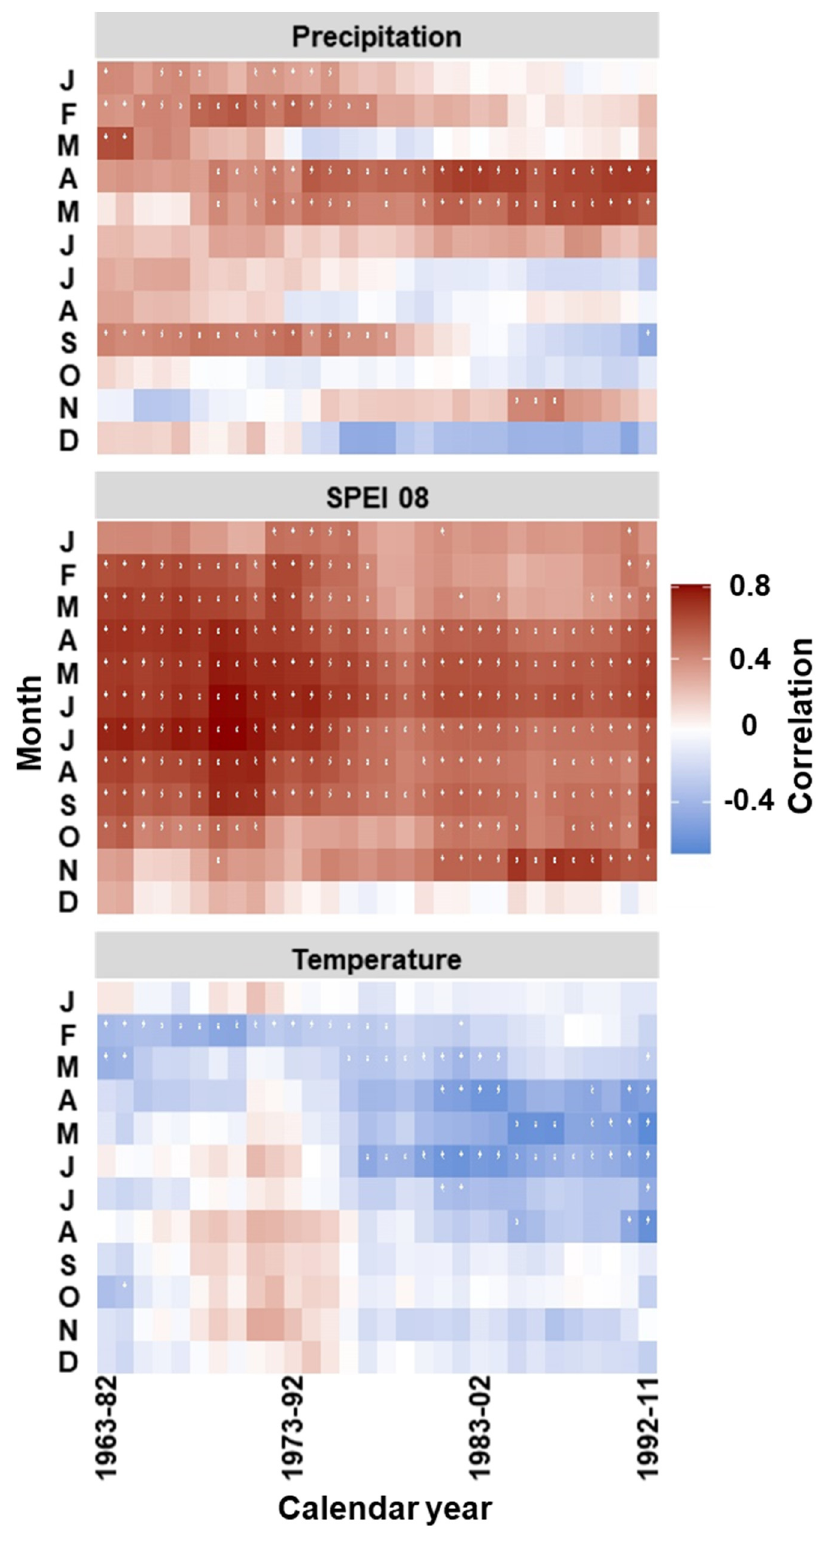
Figure 8. Moving correlations for 20-year windows between the first principal component (i.e., PC1) and the climate variables of total monthly precipitation, mean monthly SPEI 08, and temperature for the common 1963–2011 period. Moving correlation coefficients were calculated for each month of the year (from January to December). The color code represents correlation coefficients, and the white asterisks indicate significant correlations ( p <